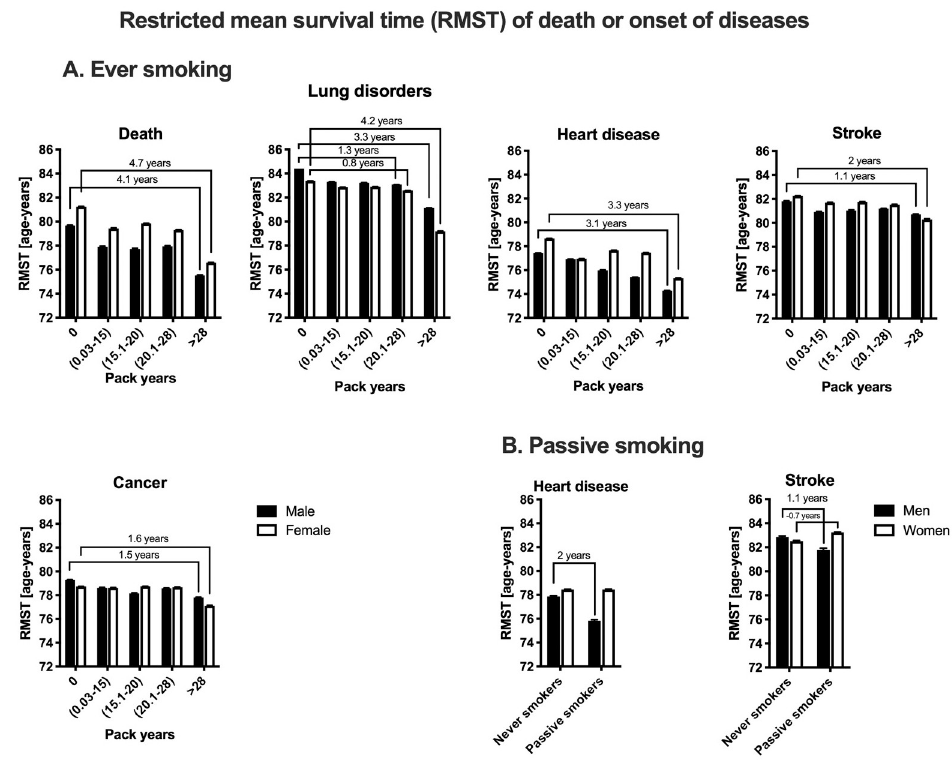
Fig 2. Restricted mean survival time (RMST) of death and disease onset in men and women smokers. The calculated RMST is based on Cox proportional hazard model of (A) smoking pack-years, and (B) passive smoke. The results are reported as RMST ± SEM. The lines are showing the number of years that was reduced by smoking from the baseline RMST age in each